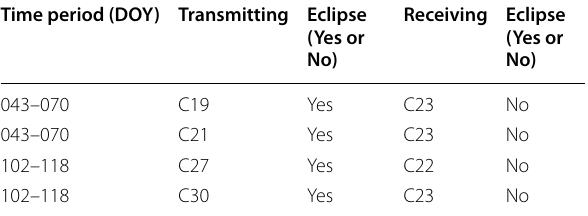
Table 6 Transmitting and receiving information of ISL Time period (DOY) Transmitting Eclipse